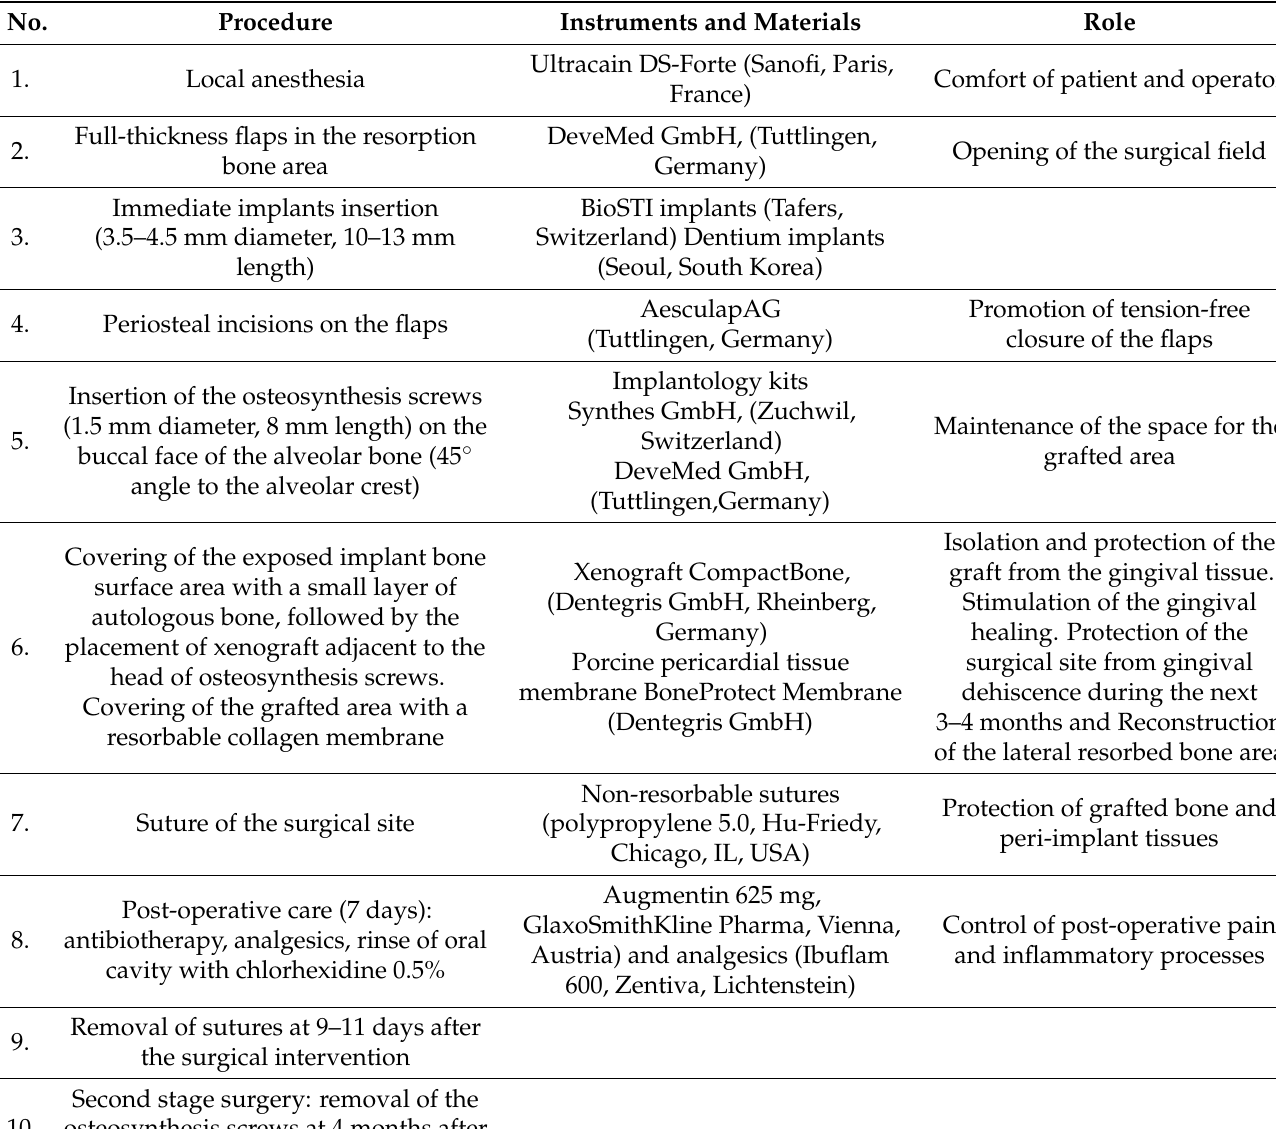
Table 3. Operative protocol in S-GBR technique and immediate implant